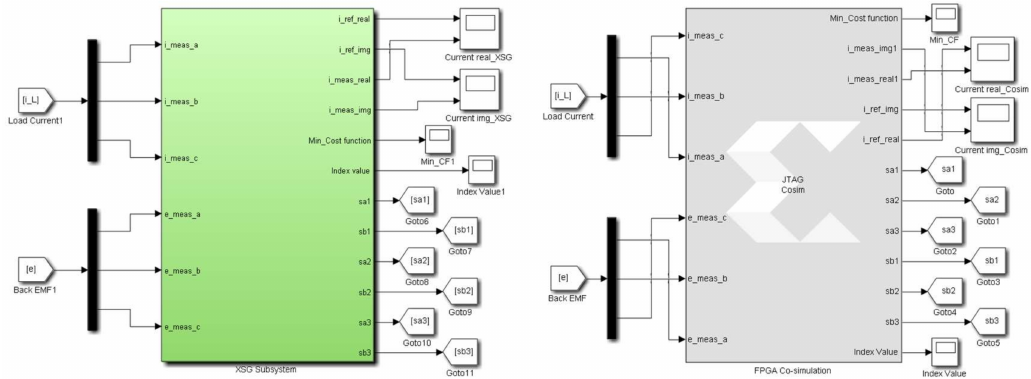
Figure 9. FS-MPC implementation in XSG and HIL co-simulation.